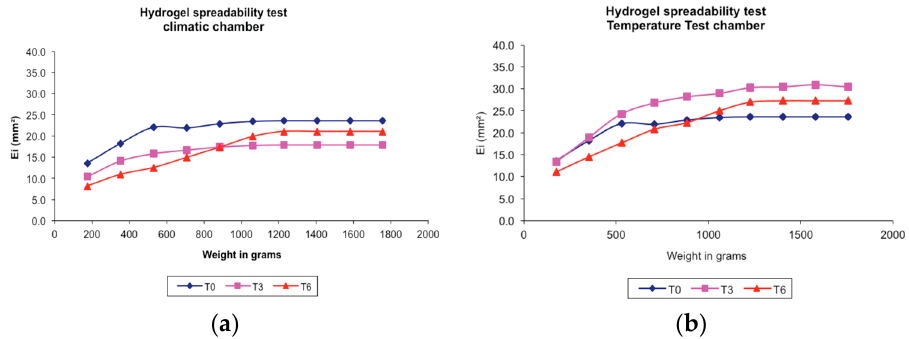
Figure 5. Spreadability test of hydrogel-based formulation of ethanolic extract of P. granatum peels (2% w / w ) in different storage conditions. ( a ) Climatic chamber; ( b ) Temperature test chamber; T0: after production; T3: 3 months; T6: 6 months. Results are represented by means ( n = 3).